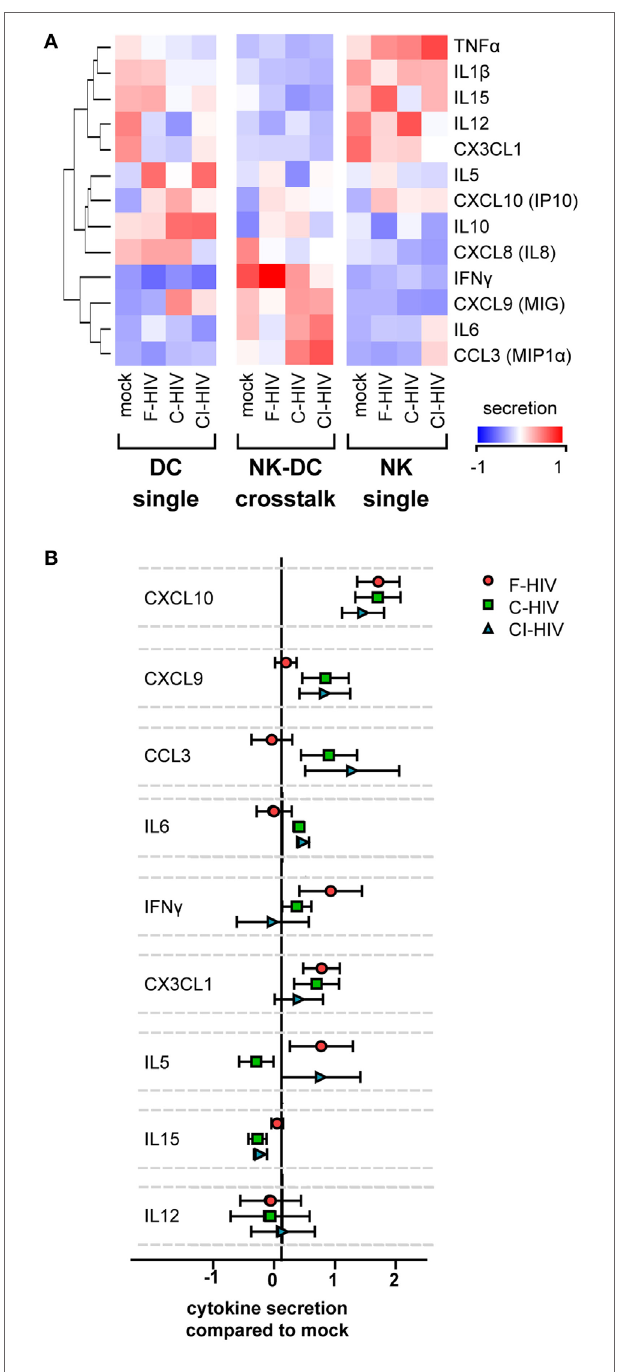
FigUre 4 | Cytokine secretion profiles in the natural killer (NK)–dendritic cell (DC) cross talk assay. DCs and NK cells were kept in single cultures, or in cross talk cultures consisting of NK cells and DCs from the same donor at a 1:1 ratio and exposed to 1 μ g/ml F-HIV, complement-opsonized HIV (C-HIV), CI-HIV, or mock treated for 24 h. The experiment was replicated four times using cells derived from four different donors. (a) The supernatants were harvested, and the concentration of cytokines was determined using a cytometric bead array or ELISA. The values were normalized (centered) and a heat map was created. (B) Cytokine concentration in the NK–DC cross talk cultures were normalized to the mock treated samples. Boxplots show mean ±